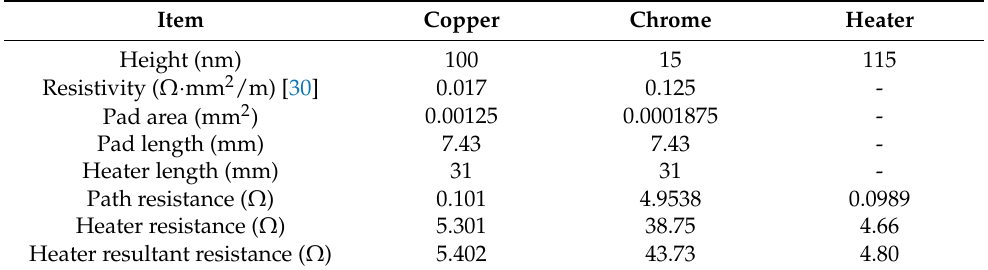
Table 2. Measurements and common theoretical calculations of the copper-chrome-based heater.